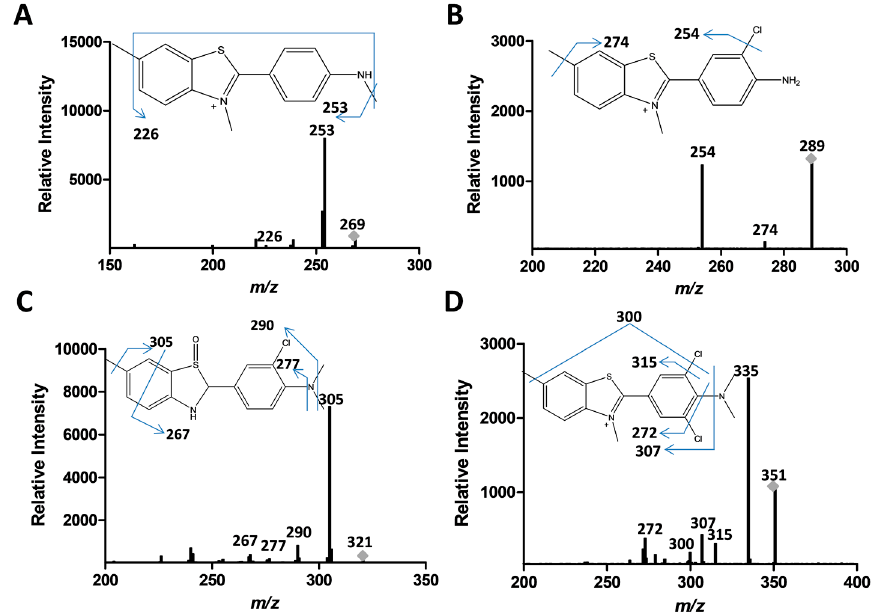
Figure 5. Tandem mass spectrometry fragmentation analyses of proposed intermediates produced after ThT degradation by UV + H 2 O 2 ( m / z of 269, panel ( A )) or CPO + H 2 O 2 as shown in panels ( A , B ) ( m / z of 289); ( C ) ( m / z of 321) and ( D ) ( m / z of 351).